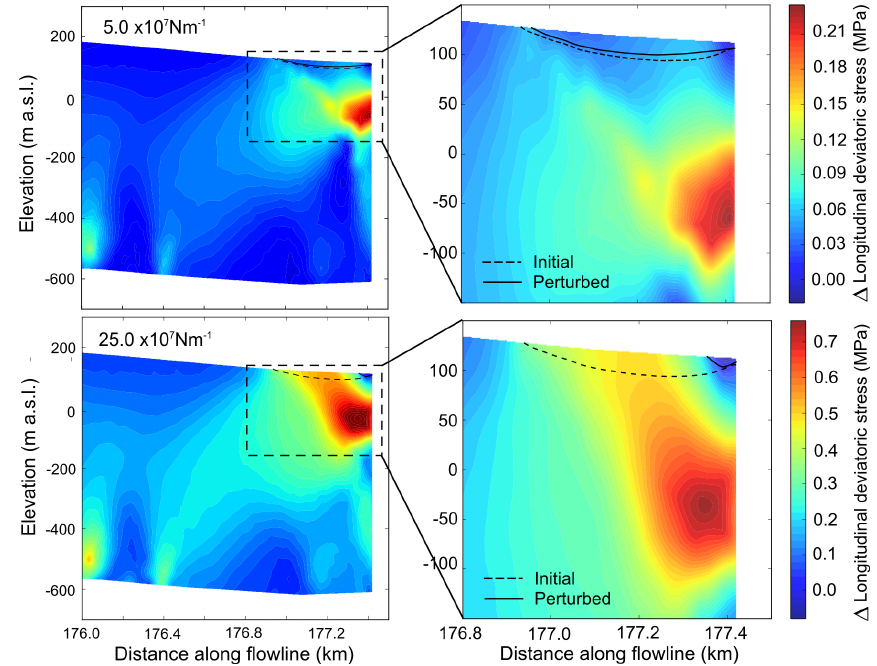
Fig. 7. Change in longitudinal deviatoric stress caused by applying a backstress of both 5.0 × 10 7 Nm − 1 and 25.0 × 10 7 Nm − 1 to the terminus, over a vertical range of +15 to − 120m (first timestep). Solid lines show the depth of the crevasse field in the initial state and dashed lines show crevasse depth with backstress applied. The lower backstress value causes little change in the modelled crevasse